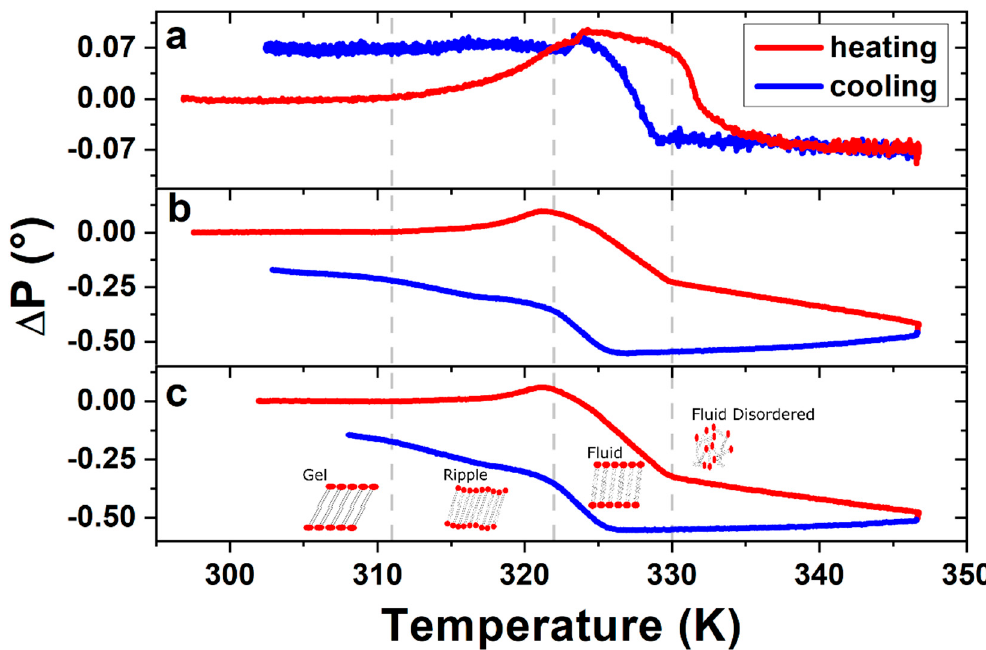
Figure 3. Ellipsometric changes in polarizer angle ∆ P of DPPC bilayer, measured during ( a ) the first, ( b ) the second and ( c ) the third heating–cooling cycle. Vertical dashed lines indicate the phase transition temperatures as described in the text. The ∆ P signal of the following heating–cooling cycles show the same characteristics of figures ( b ) and ( c ), leading to the conclusion that the structure formed after the first heating–cooling cycle remains stable.